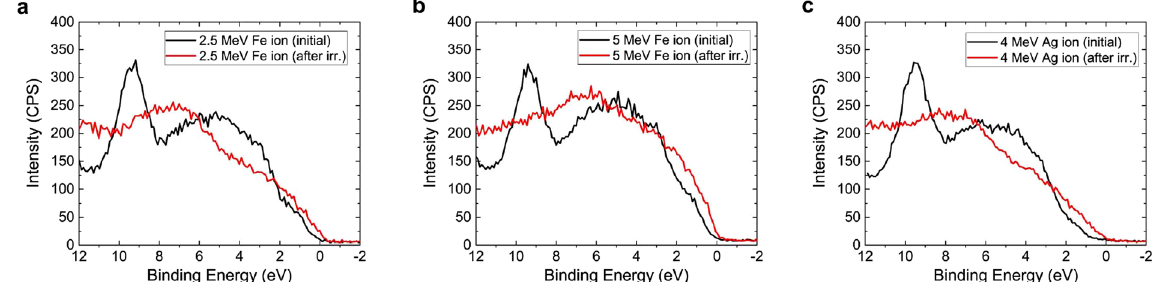
Figure 7. Change of valence band spectra after heavy ion irradiation. The change of XPS spectrum near the valence band region after irradiation with ( a ) 2.5 MeV Fe, ( b ) 5 MeV Fe, and ( c ) 4 MeV Ag ions at a fluence of 10 16 ions/cm 2